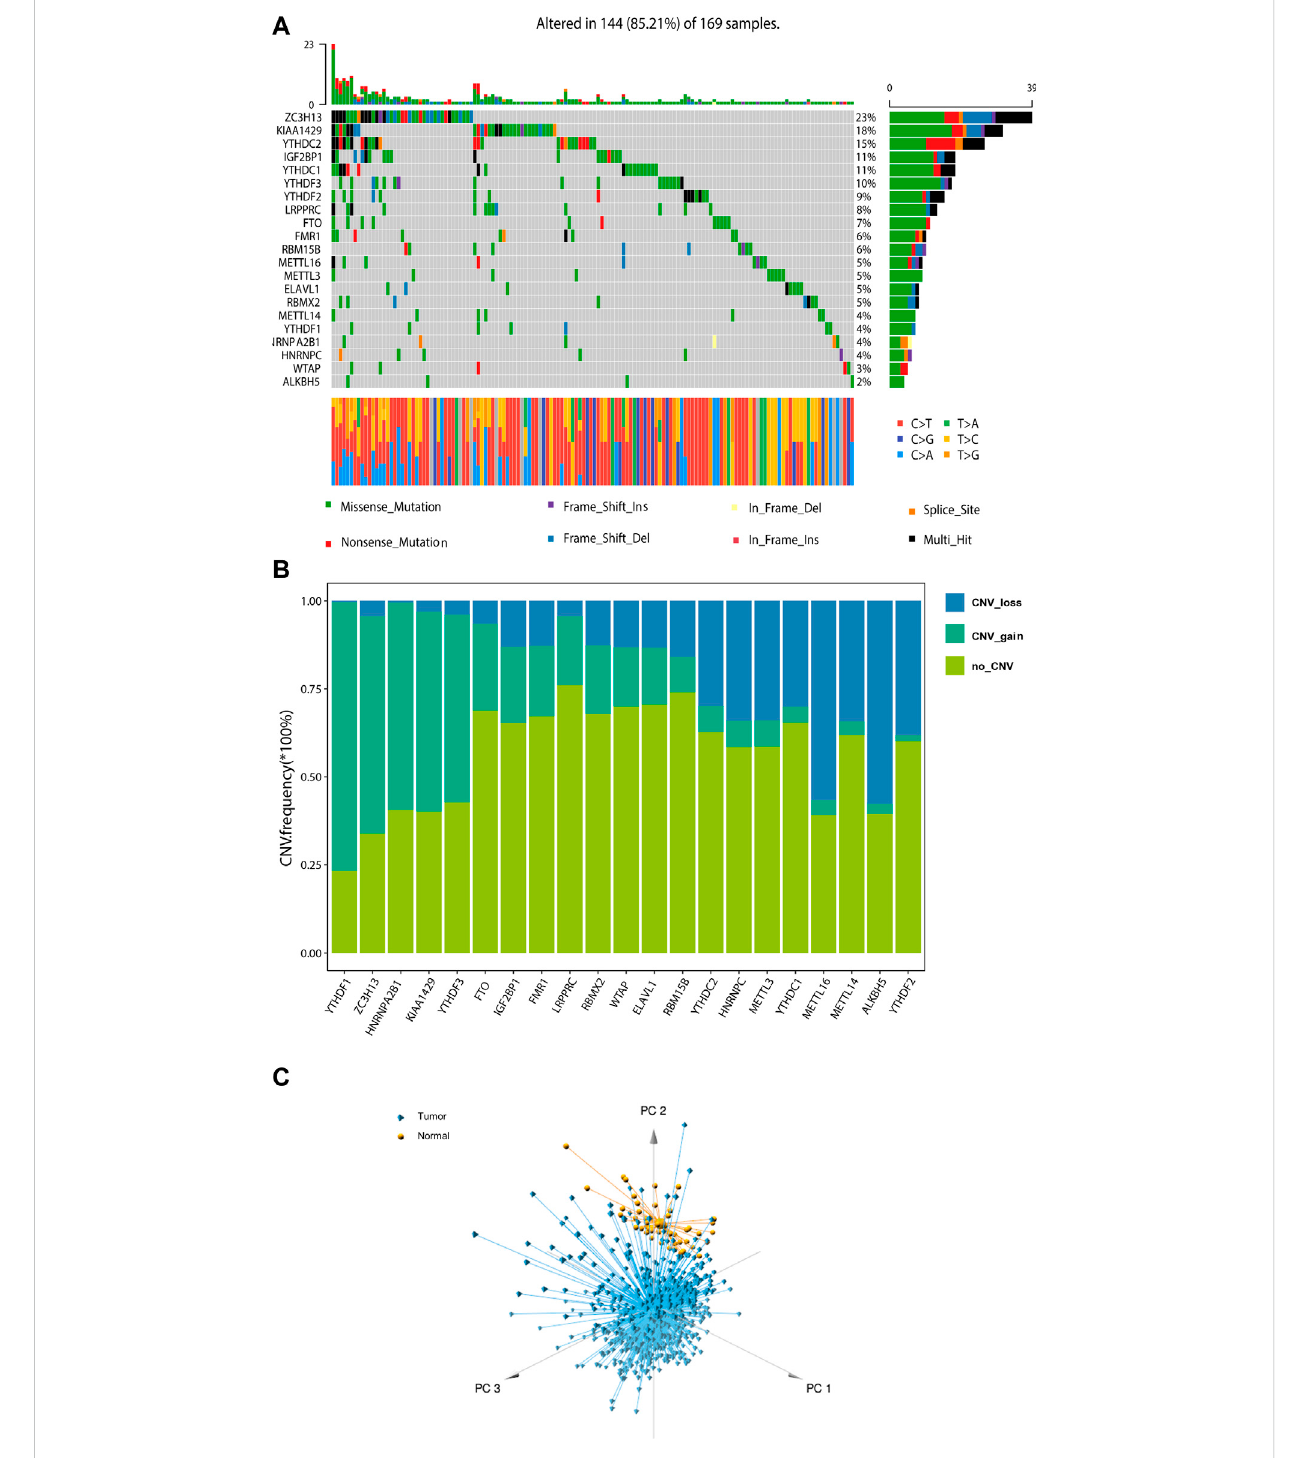
FIGURE 1 Landscape ofgeneticof m6Aregulatorsincolorectal cancer. (A) Themutationfrequencyof 21m6A regulators in169patients with CRC fromTCGA cohort. (B) Bar graphs showing the frequency of CNV gain (green), loss (blue) and non CNV (yellow) of m6A regulators in TCGA-COAD/READ cohort. (C) Principal component analysis for the expression pro fi les of 21 m6A regulators to distinguish tumours from normal samples in TCGA